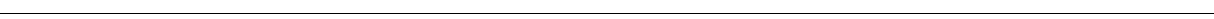
Fig. 4 CC domain enables processive polyUb chain synthesis by TRAF6. a , b Processive polyUb chain assembly by TRAF6. Time-course analysis of polyUb chain synthesis by T6RZC was performed as indicated and shown in a . The corresponding quanti fi cation was plotted as function of time in b . R ob , arbitrary observed rate of polyUb assembly. c , d Lack of CC impairs polyUb chain synthesis by TRAF6. Time-course analysis of polyUb chain synthesis was performed to compare T6RZC and T6RZ. Time-dependent accumulation of polyUb chains was shown in c and quanti fi ed in d . It is needed to note we used a lot more of T6RZ in order to enhance the rate by T6RZ so we could visualize the products and do the reliable quanti fi cation. R ob , arbitrary observed rate of polyUb assembly. e – g Km determination of Ub~Ubc13 for T6RZC and T6RZ. Pre-charged Ub~Ubc13/Uev2 were titrated into T6RZC or T6RZ and incubated at 30 °C for 30 min. The products were immunoblotted ( e , f ), quanti fi ed and plotted as function of Ub~Ubc13/Uev2 in g . The Km values